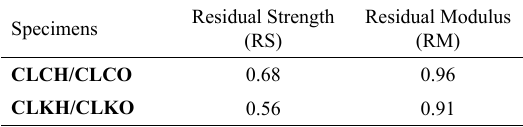
Table 5. Residual properties: strength and elastic modulus.